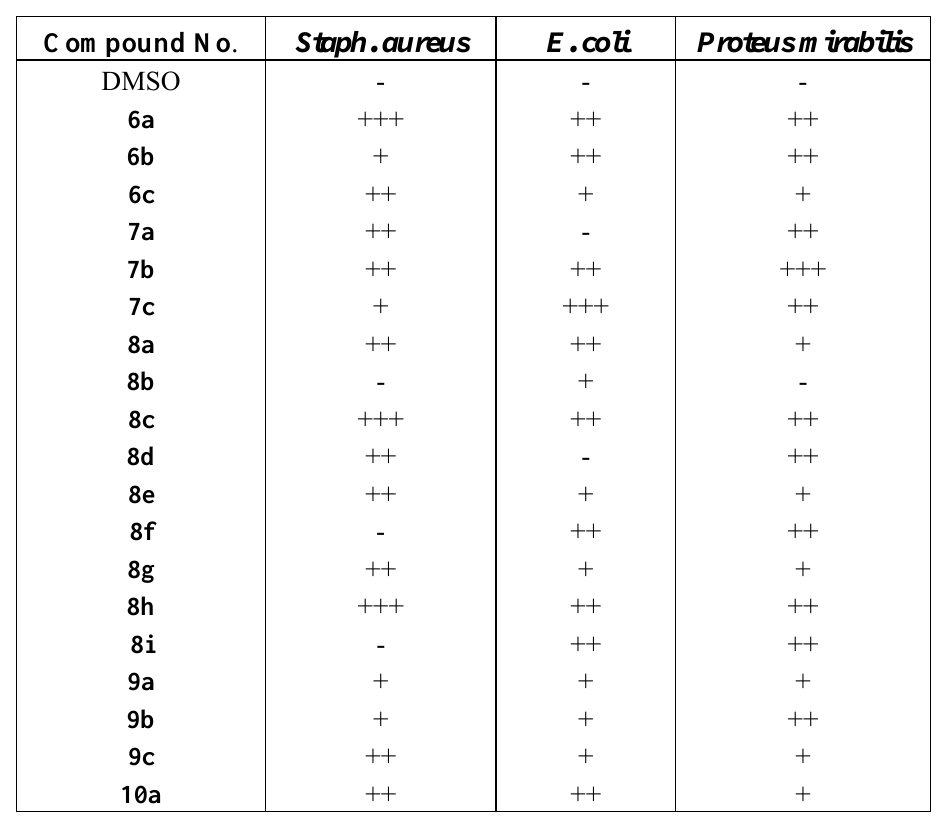
Table 1. Antibacterial Activity of New